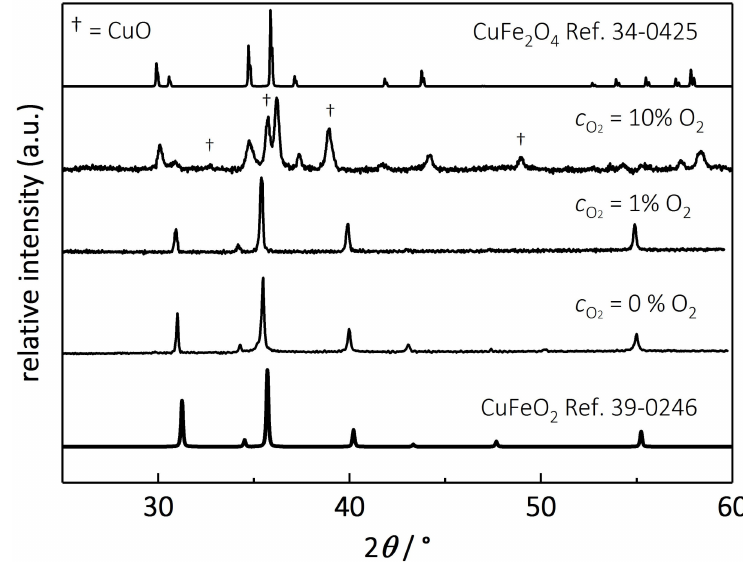
Figure 1. XRD patterns of CuFeO 2 calcined under nitrogen as well as 1% and 10% oxygen mixed in nitrogen. Additionally, the reference spectra of CuFeO 2 (JCPDS 39-0246) and CuFe 2 O 4 (JCPDS 34-0425) are